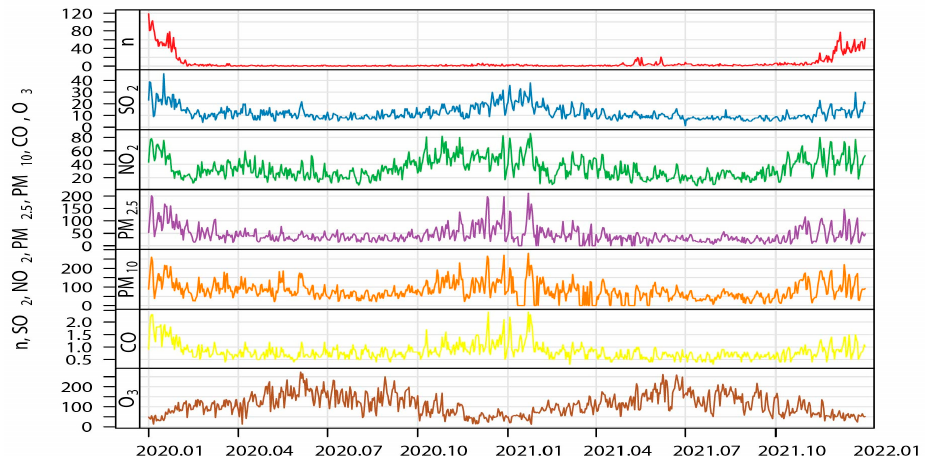
Figure 1. The distributions of air pollutants concentration and daily influenza cases number in Jinan, China, during